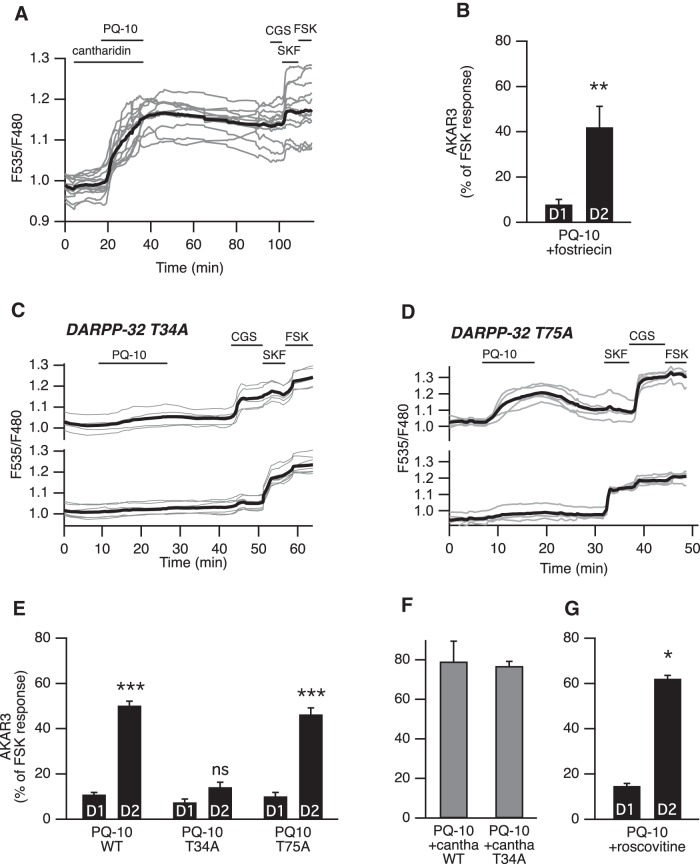
DARPP-32-mediated phosphatase inhibition favors PKA signaling in D2 MSNs. A, PP-1 and PP-2A were inhibited with cantharidin. Cantharidin (30 µm) alone did not change the basal ratio but strongly increased the AKAR3 response to PQ-10 (100 nm) in all MSNs. These responses were not reversible, making the final identification of D1 and D2 MSNs impossible (gray bars in F, which represent the responses of all MSNs). B, D2 MSNs responded selectively to PQ-10 (100 nm) even when the PP-2A inhibitor fostriecin (200 nm) was applied (n = 4, paired Student’s t test; **p < 0.01). C–E, Mutation of the Thr34 to Ala in DARPP-32 (DARPP-32 T34A) strongly reduced the effect of PQ-10 (100 nm) in D2 MSNs, whereas the selective effect of PQ-10 on D2 MSNs remained in brain slices from animals bearing the Thr75 to Ala mutation in DARPP-32 (DARPP-32 T75A). C, D, Representative experiments performed with DARPP-32 T34A (C) and DARPP-32 T75A (D) knock-in mice. Each trace on the graph indicates the ratio measurement on MSNs expressing AKAR3 and is identified as D1 or D2 according to their response to either SKF-38393 (SKF, 1 µm) or CGS 21680 (CGS, 1 µm), respectively. The thick black line represents the average of all the traces in each group. E, The data expressed as the mean ± SEM were analyzed by two-way ANOVA: genotype effect, F(2,72) = 71.12, p < 10−
4; D1/D2 effect, F(1,72) = 333.07, p < 10−
4; genotype × D1/D2 interaction, F(2, 72) = 49.53, p < 10−
4. Bonferroni’s post hoc test: ***p < 0.001. F, In wild-type (WT) mice and DARPP-32 T34A mutants, and in the presence of cantharidin (30 µm), all MSNs responded to PQ-10 (100 nm) with an increase in AKAR3 ratio such that D1 and D2 MSNs could not be distinguished (n = 5 for both). No significant difference was obtained between wild-type and DARPP-32 T34A mutant (unpaired Student's t test, p > 0.05). G, D2 MSNs responded selectively to PQ-10 (100 nm) even when the Cdk5 inhibitor roscovitine (10 µm) was applied (n = 4, paired Student’s t test; *p < 0.05).